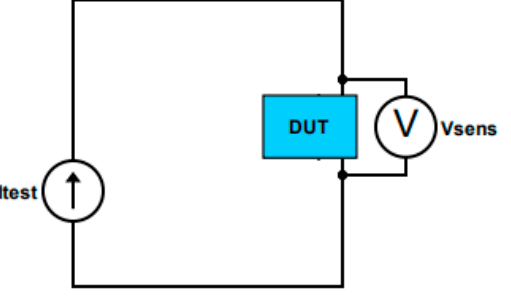
Figure 3. Calibration electrical circuit for sensing the drain-source voltage, V ds .